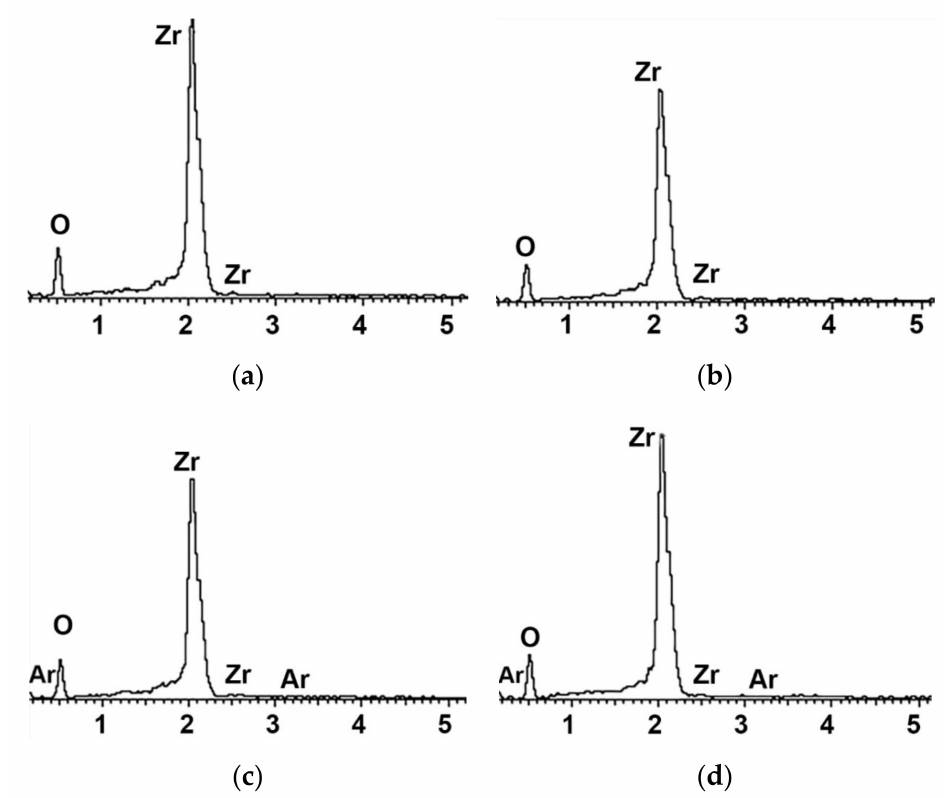
Figure 4. Energy-dispersive X-ray spectroscopy elemental spectrums of the ( a ) control group, ( b ) 60 s group, ( c ) 300 s group, ( d ) 600 s